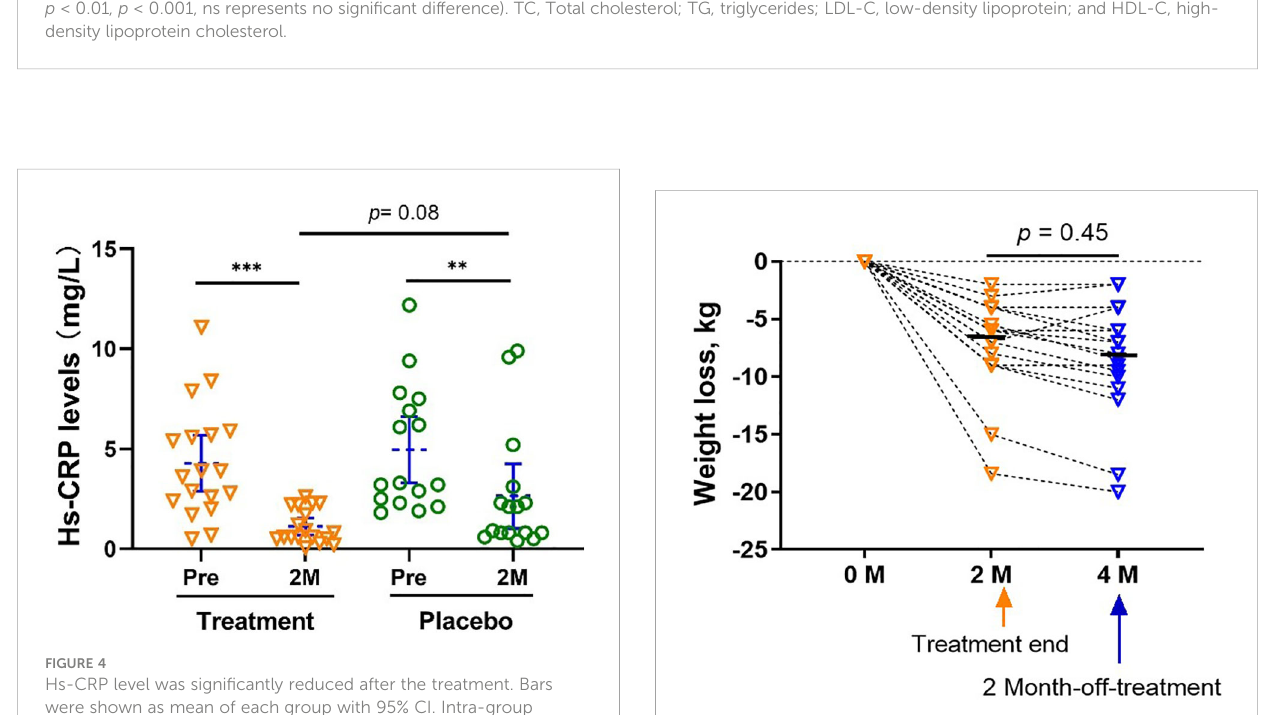
FIGURE 5 Weight did not rebound in the treatment group at a follow-up visit 2 months after the treatment. Bars were shown as mean of each group. The analyses were performed using one-way ANOVA followed by Bonferroni post hoc by Prism 9